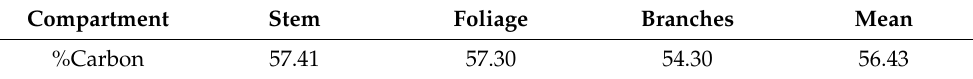
Table 4. Conversion factor for each compartment of the tree.